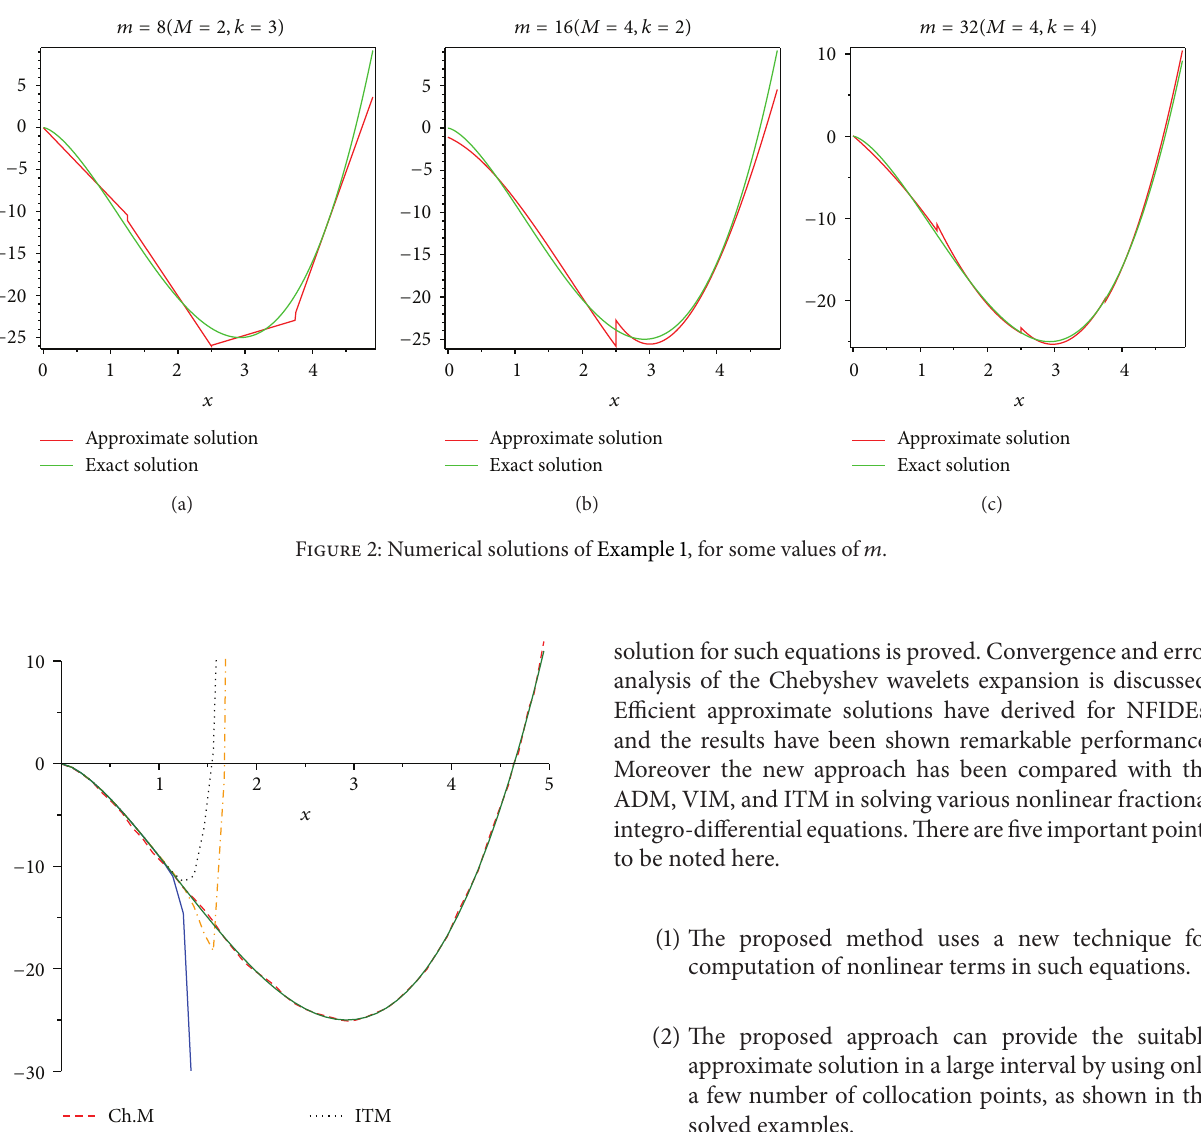
, 𝑦 4 (𝑥) of the ADM, ITM, and VIM for 𝛼 = 0.80 and 𝛼 =